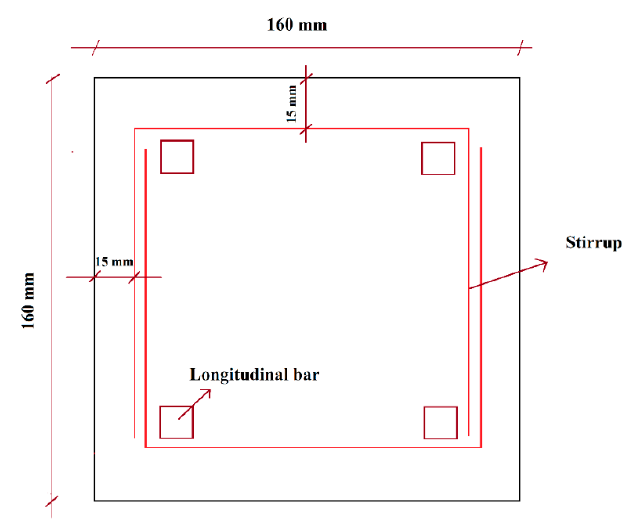
Figure 9. Cross section of bamboo composite reinforced concrete beam.